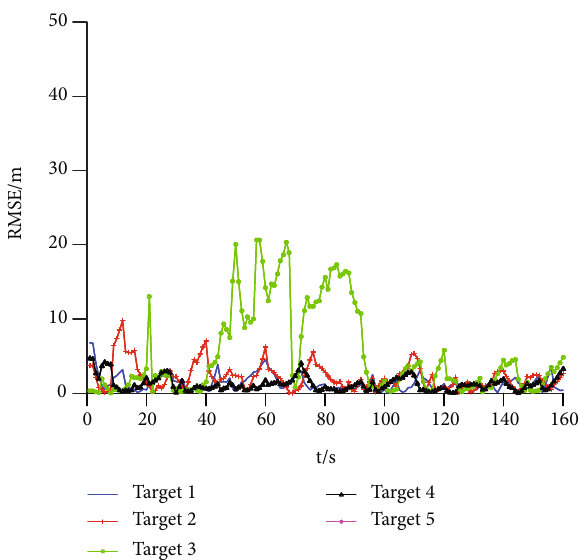
Figure 11: The velocity RMSE for four targets (CA model).